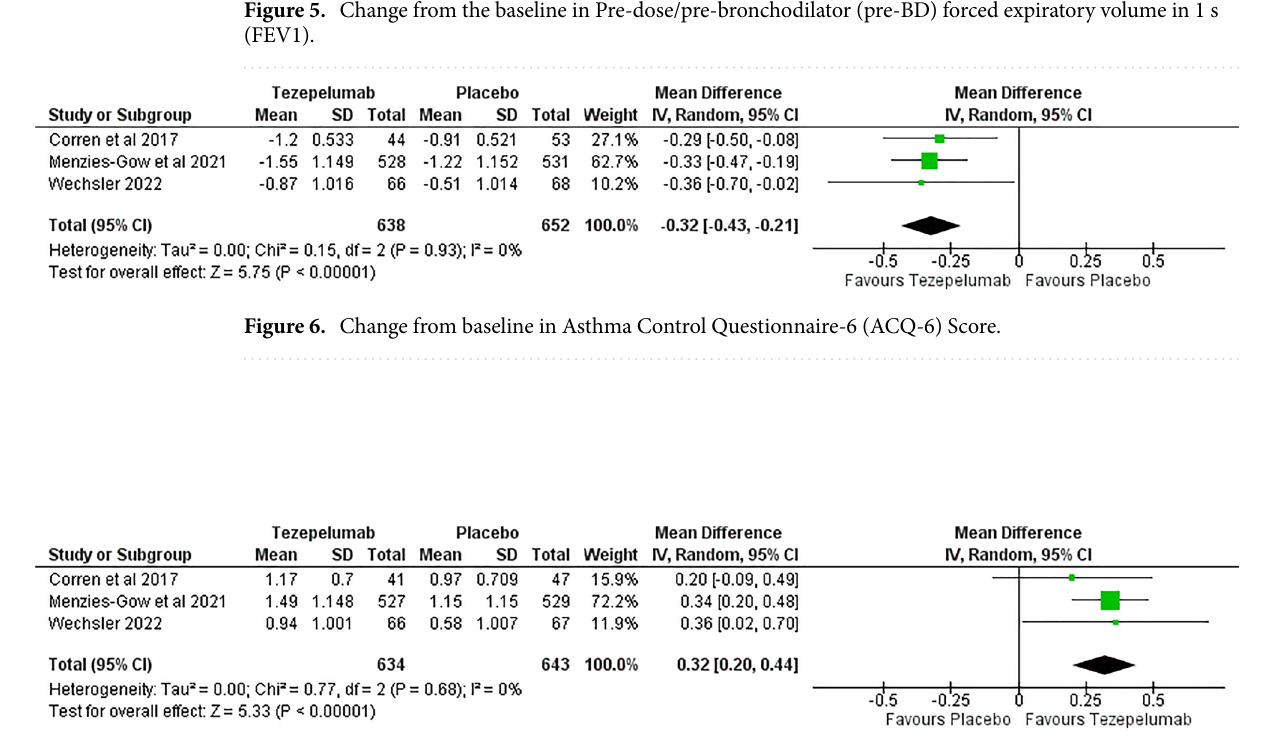
Figure 7. Change from baseline in Standardized Asthma Quality of Life Questionnaire for 12 years and older (AQLQ + 12) total